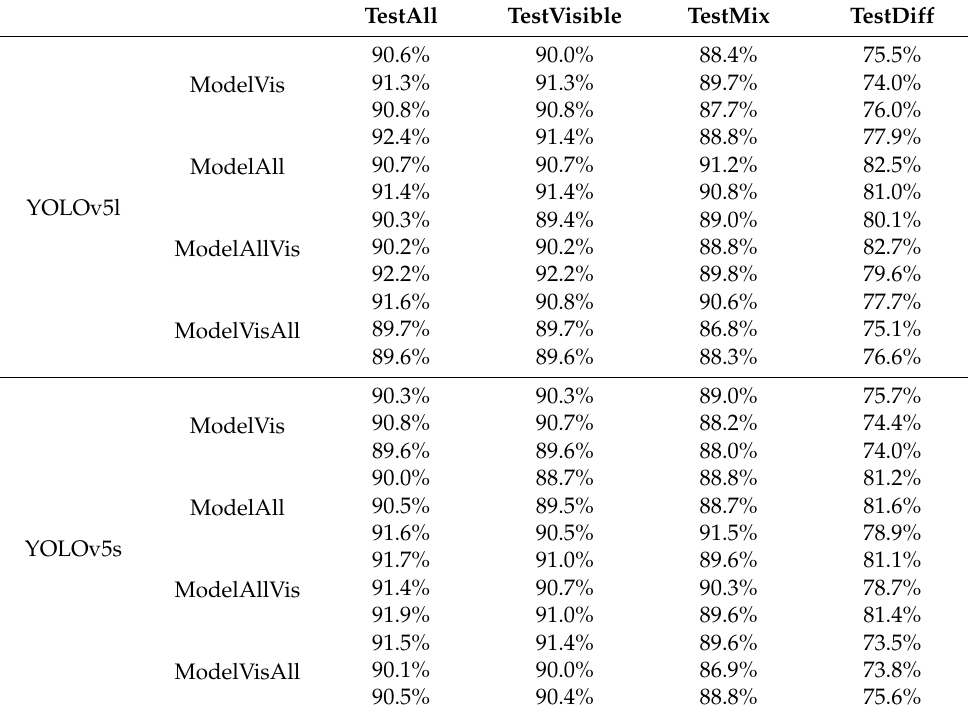
Table 1. Values of mAP@.5:.95 for all investigated models. TestAll TestVisible TestMix TestDiff